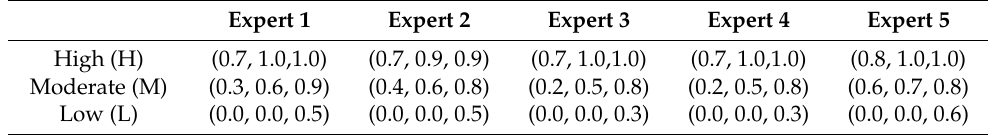
Table A1. Triangular fuzzy membership functions of the five experts.